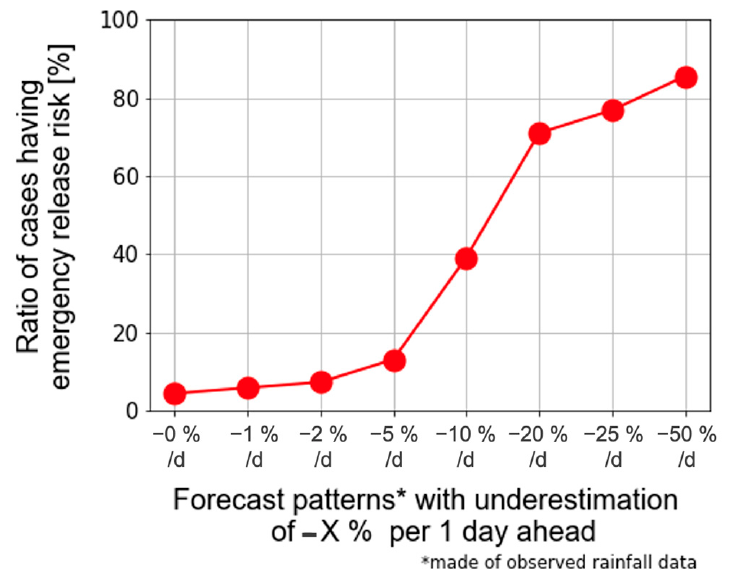
Figure 16. Ratio (%) of cases with an emergency release risk when using variously underestimated Figure 16. Ratio ( %) of cases with an emergency release risk when using variously underestimated rainfall forecasts for all pre-release cases. rainfall forecasts for all pre-release cases.